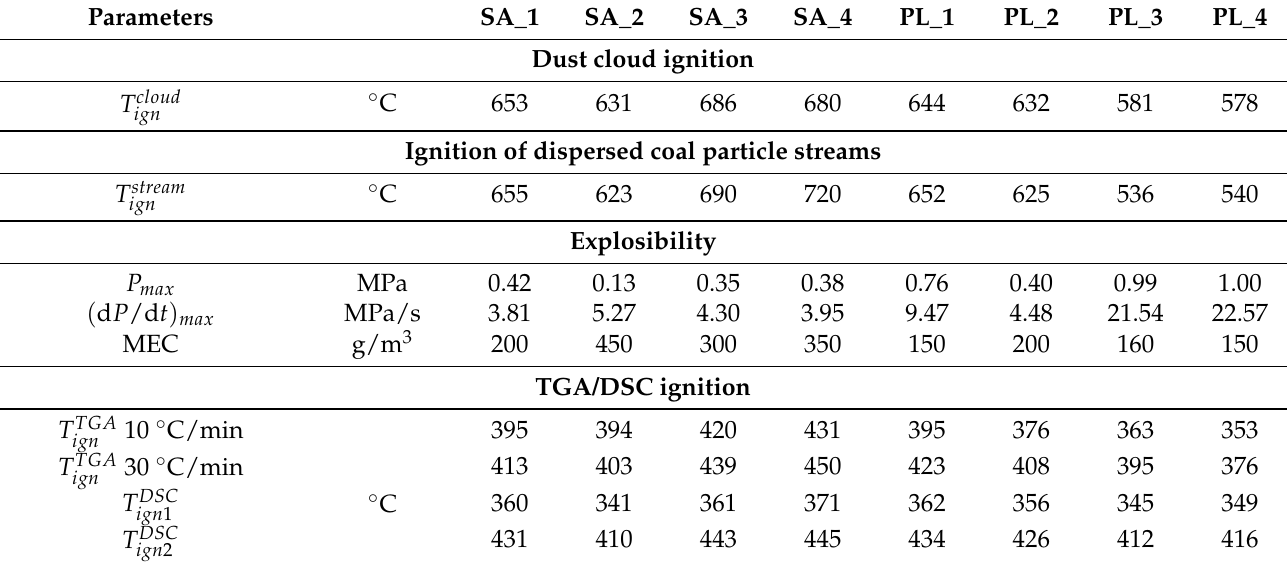
Table 3. The ignition parameters for the tested